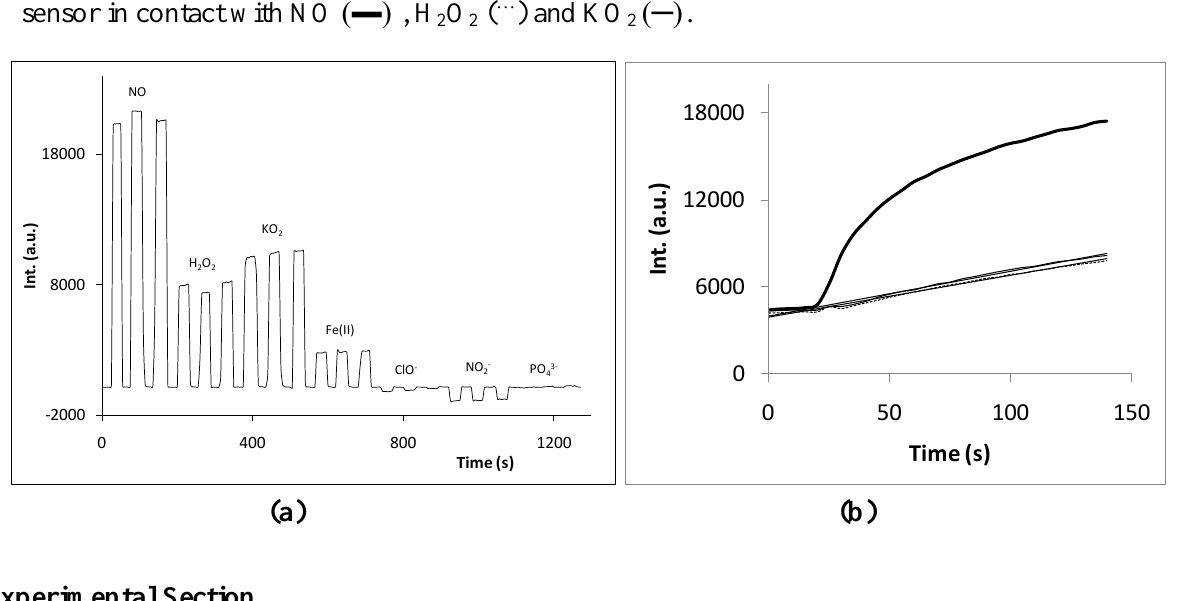
Figure 6. Interfering species assessment (concentration of all species is about 400  M): (a) steady state fluorescence after one hour; and (b) initial fluorescence variation of the sensor in contact with NO (▬) , H